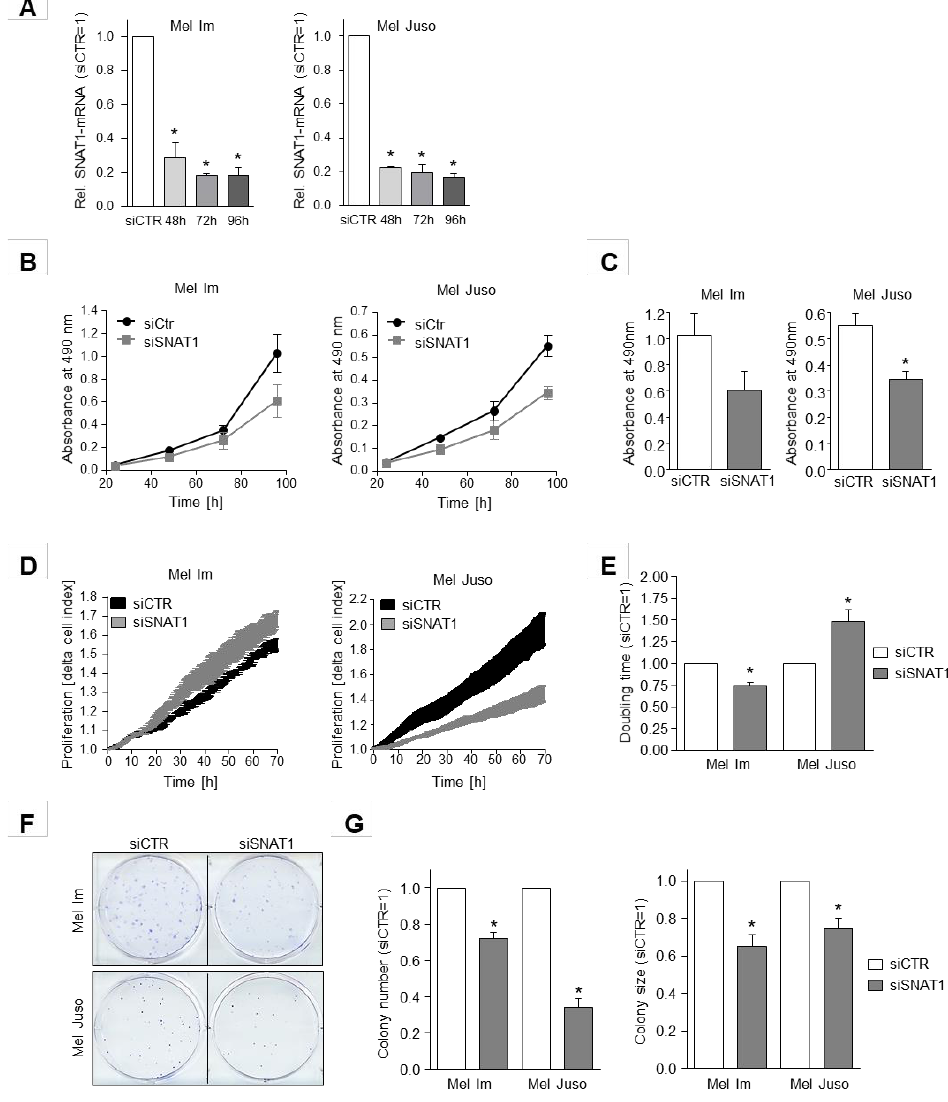
Figure 3. Influence of SNAT1 downregulation on cell proliferation. ( A ) Relative SNAT1 mRNA- expression normalized to β -actin after 48, 72, and 96 h siSNAT1 transfection, compared to siCTR cells of indicated melanoma cell lines. Values represent the mean ± SEM of 3 independent experiments. ( B , C ) Proliferation analysis using XTT assay of indicated melanoma cell lines after siSNAT1 downregulation in comparison to siCTR cells. ( B ) Exemplary absorbance at 490 nm 24, 48, 72, and 96 h after seeding siSNAT1 and siCTR cells of Mel Im and Mel Juso into the XTT assay. ( C ) Quantification of absorbance 96 h after starting the XTT assay. (Mel Im p -value = 0.1301.) Values represent the mean ± SEM of 3 independent experiments. ( D , E ) Quantification of cell proliferation with RTCA of Mel Im and Mel Juso cells after 96 h siSNAT1 transfection in comparison to siCTR cells. ( D ) Exemplary image of real time cell proliferation curve of siSNAT1 and siCTR-transfected cells. ( E ) Quantified RTCA doubling time. Values represent the mean ± SEM of at least 3 independent exper- iments. ( F , G ) Exemplary images ( F ) and quantification ( G ) of the clonogenic assay. Colony number ( G , left ) and colony size ( G , right ) of melanoma cell lines Mel Im and Mel Juso after siSNAT1 down- regulation when compared to siCTR cells. Values represent the mean ± SEM of at least 3 independ- ent experiments. p -value < 0.05 was considered statistically significant (*).